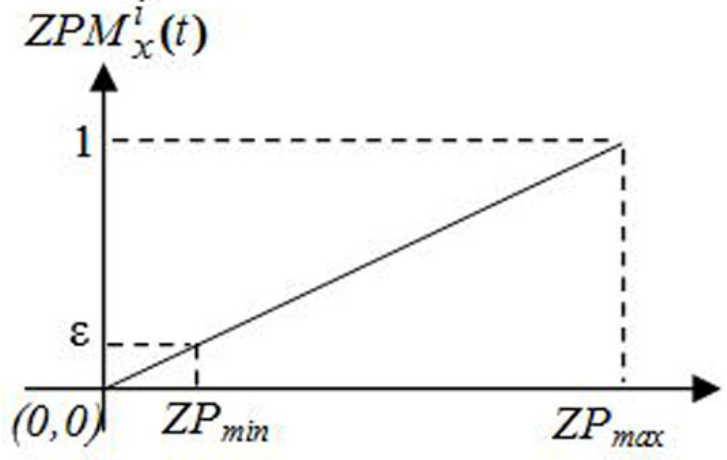
Figure 2. Function curve for zone priority.